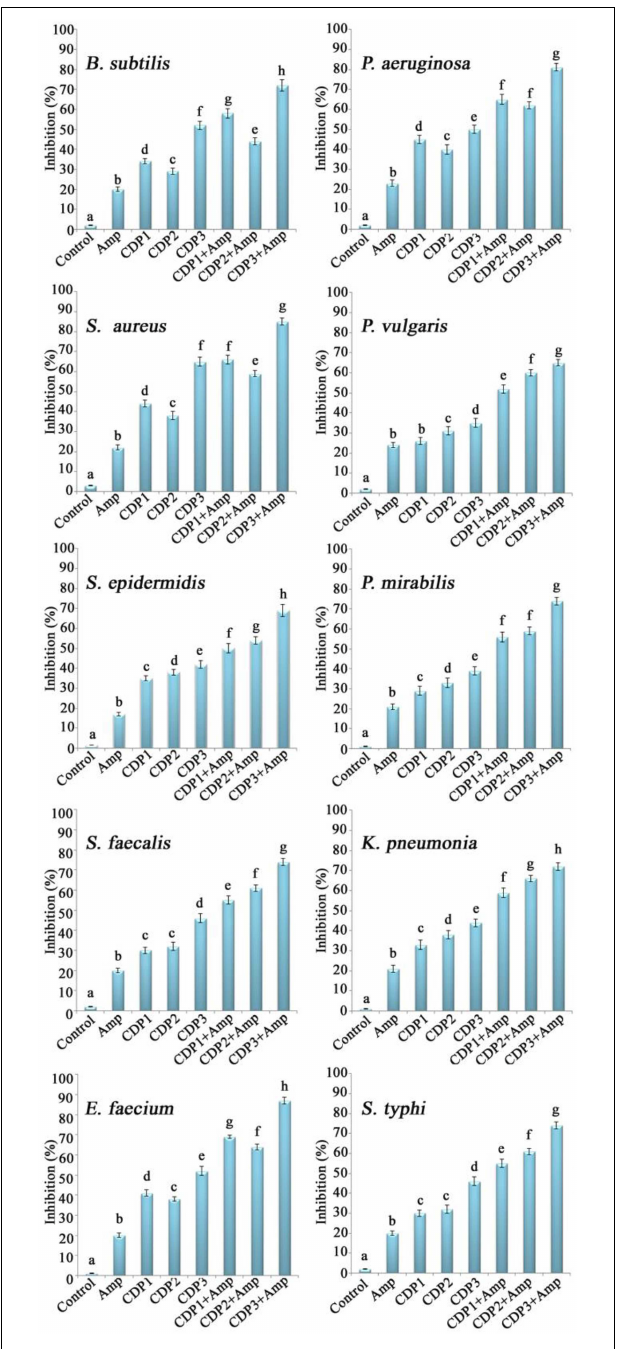
FIGURE 4 | Effects of the synergistic combination of cyclic dipeptides and ampicillin against biofilm formation by wound associated bacterial pathogens. Error bars indicate the standard deviations of three measurements. Different letters in the superscript were significantly different according to Duncan’s multiple range test ( p < 0.05).